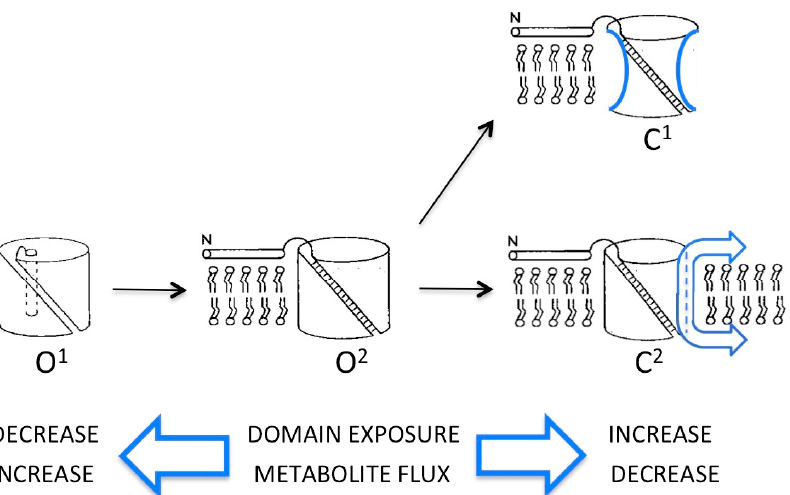
Figure 1. Schematic of open (O) and closed (C) conformers of the voltage-dependent anion-selective channel, VDAC, with the β -barrel represented as an open cylinder and the N-terminal α -helix as a narrow rod either inserted inside (O 1 ) or extended away from (O 2 and closed states) the pore lumen. Evidence in support of each conformer is described in the text. In C 1 , the sides of the cylinder are concave to signify narrowing of the β -barrel due to partial collapse of the walls. In C 2 , the cylinder has a smaller diameter due to removal (sliding) of segments of the VDAC polypeptide (represented as arrows) from the wall of the β -barrel to either membrane surface (see